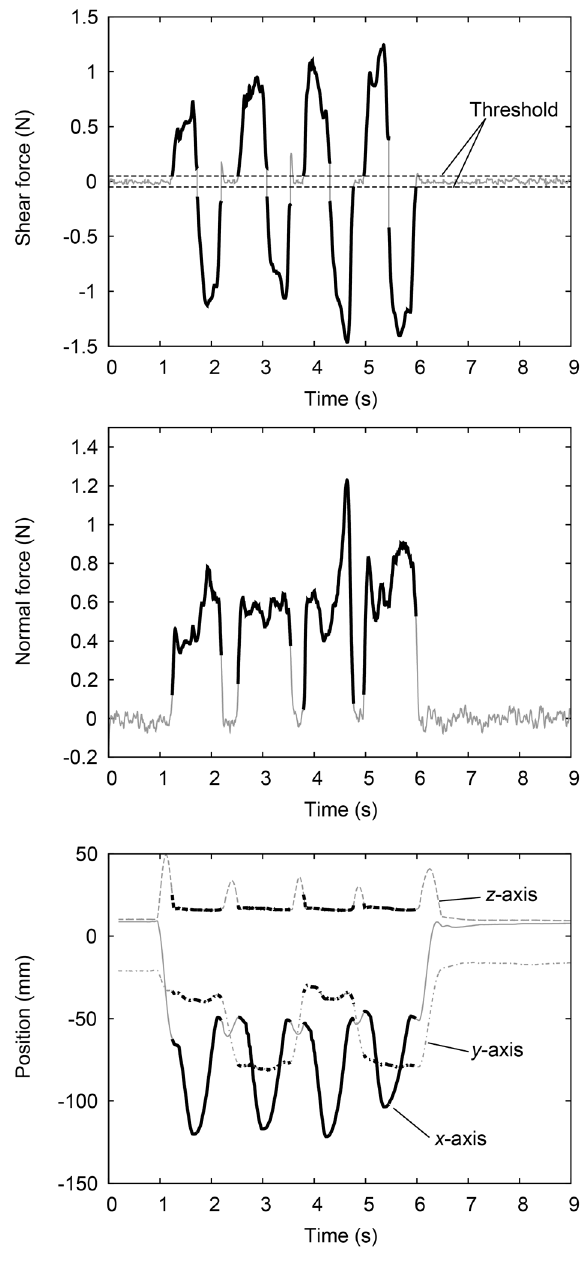
Figure 4. An example of the measurements of exploratory movements. Shear force, normal force, and finger position were measured. An example of data collected during a discrimination trial is shown. The bold parts in each panel indicate the parts extracted for further analysis. Furthermore, for each trial, the average of the shear force was calculated for each extracted single stroke. Next, the average of the shear force for each trial was calculated using the averages calculated from each single stroke. A friction coefficient for each trial was calculated by dividing the average of the shear force for each trial by the average of the normal force for each trial. In addition, for the perceptual tasks, the number of strokes and the percentage of correct answers were computed. The average number of strokes for each condition and each participant was